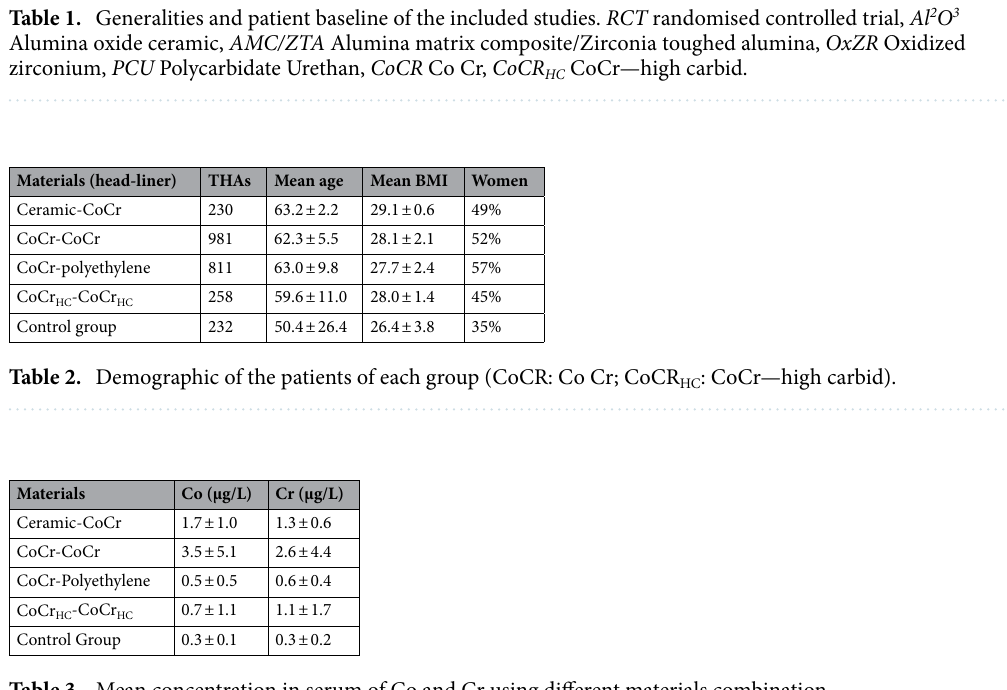
Table 3. Mean concentration in serum of Co and Cr using different materials combination.